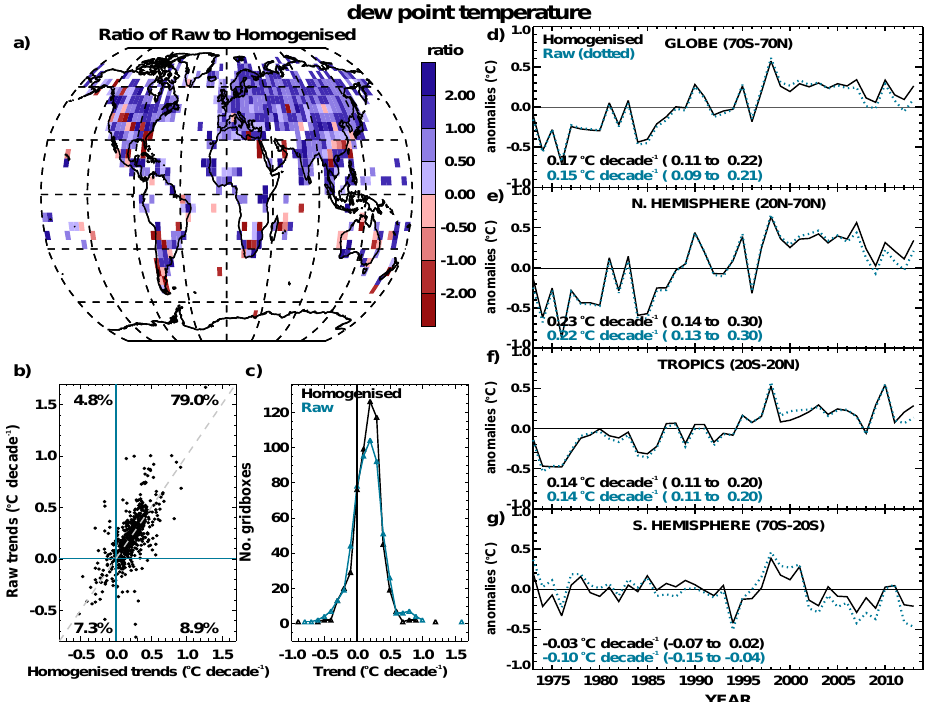
Figure 8. Comparison of decadal trends from 1973–2013 between raw and homogenised monthly mean dew point temperature. (a) Ratio of raw to homogenised trends for each grid box (a value of > 1 means that the raw trend is greater than the homogenised trend). (b) Scatter plot of raw verses homogenised decadal trends for each grid box with percentage presence in each quadrant. (c) Trend size distribution for raw and homogenised grid boxes. (d) Large-scale area-average time series (weighted by the cosine of the latitude) and decadal trends calculated using the median of pairwise slopes with 5th to 95th percentile slopes as confidence